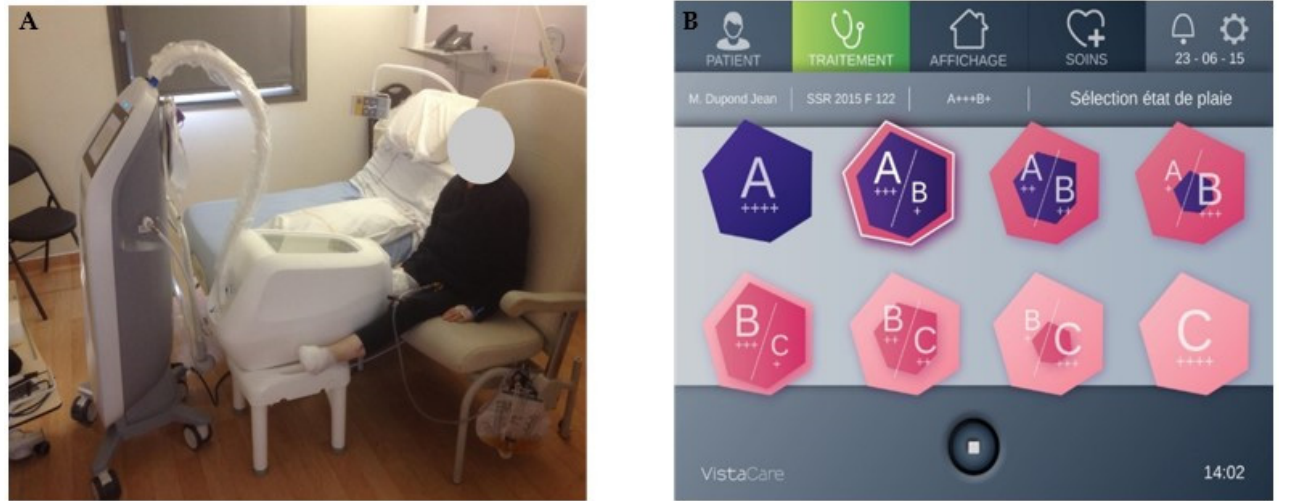
Figure 1. Vistacare ® device. ( A ) The generator and the chamber where the leg with the wound is placed; ( B ) control screen of the Vistacare ® device displaying the different pictograms for each set (a (+) sign corresponds to 3 h of treatment within a 12-h cycle).